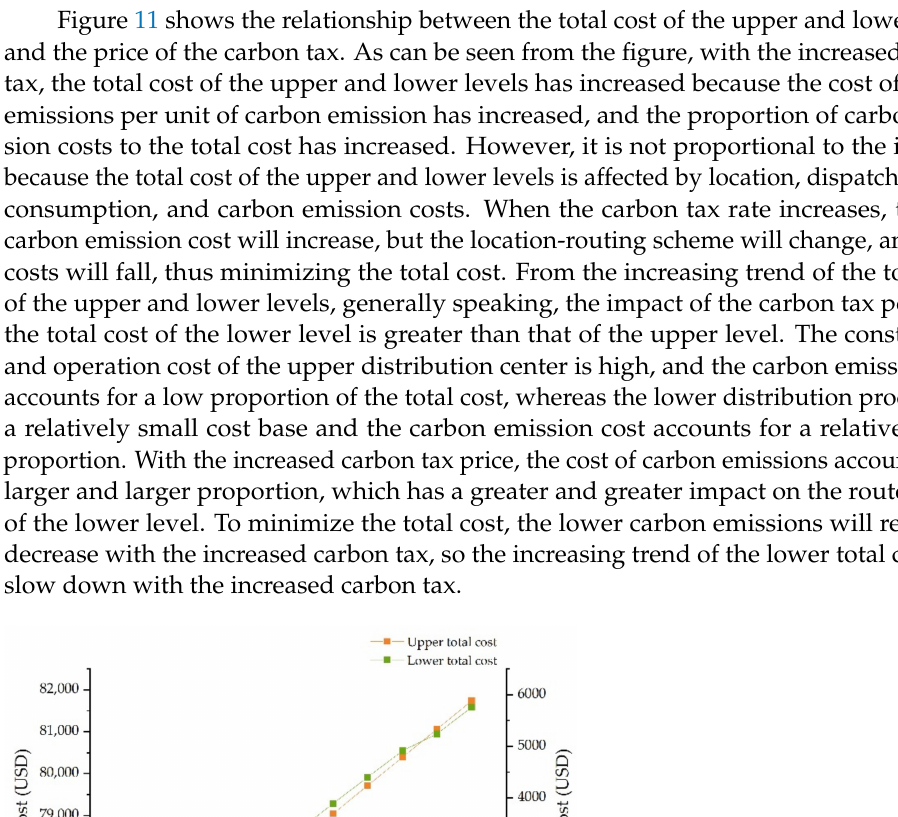
Figure 10. The relationship between total carbon emissions and carbon tax prices.